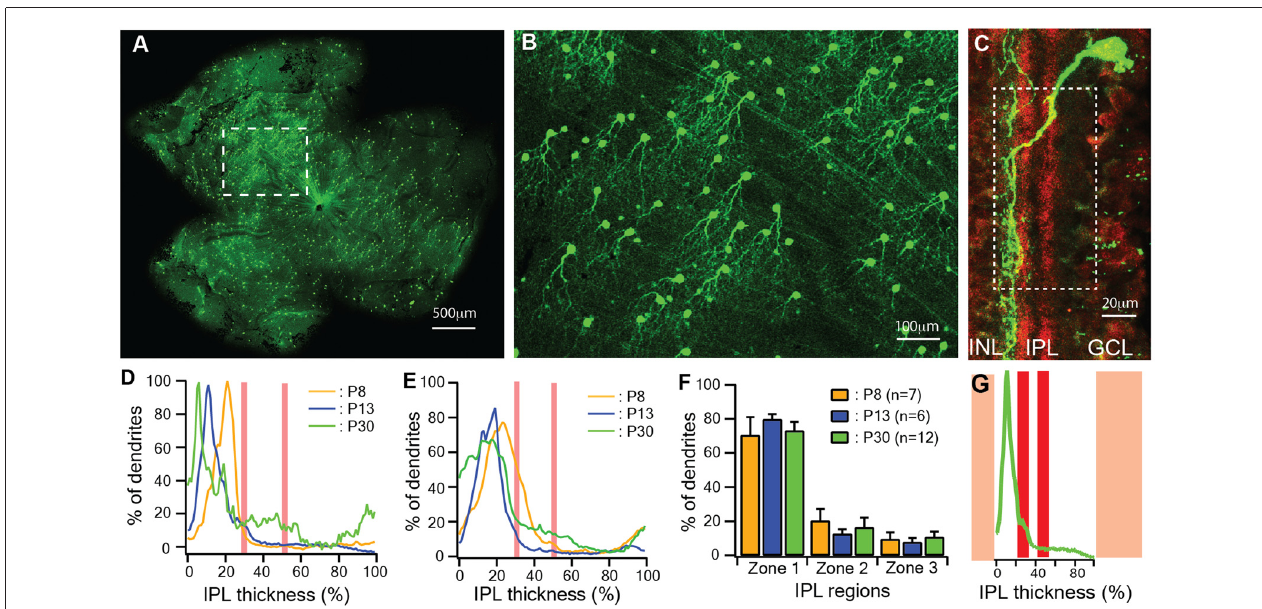
FIGURE 1 | The dendritic ramification of JamB retinal ganglion cells (J-RGCs) reaches adult pattern early during postnatal development. The retinas of JamB-CreER:Thy1-YFP mice were stained with an anti-green fluorescent protein (GFP) antibody and flat mounted for dendritic tree imaging or sectioned for ramification analysis. (A) A representative image of a whole mount retina of a JamB-CreER:Thy1-YFP mouse. (B) An enlarged view of the retina area indicated by the dashed line box in (A) showing YFP expressing J-RGCs. (C) Immunolabeling of cholinergic amacrine cell dendritic plexus (red) and the dendritic plexus of a J-RGC (green) of a cross section of a P30 JamBCreER:Thy1-YFP mouse retina. (D) Representative dendritic density distribution curves of three J-RGCs from a postnatal day 8 (P8), a P13 and a P30 retina. (E) Average dendritic density profile as a function of the inner plexiform layer (IPL) depth measured as the fluorescent intensity of the J-RGCs at three different ages (P8: 2 mice, 7 cells; P13: 2 mice, 6 cells; P30: 3 mice, 12 cells). (F) Average dendritic distribution of the J-RGCs in three IPL zones at three ages. (G) The fluorescent intensity profile of the dendritic plexus of the J-RGC in (C) plotted as a function of the IPL depth (green). The red bands indicate the cholinergic amacrine cell dendritic plexus. The yellow bands indicate the GCL and